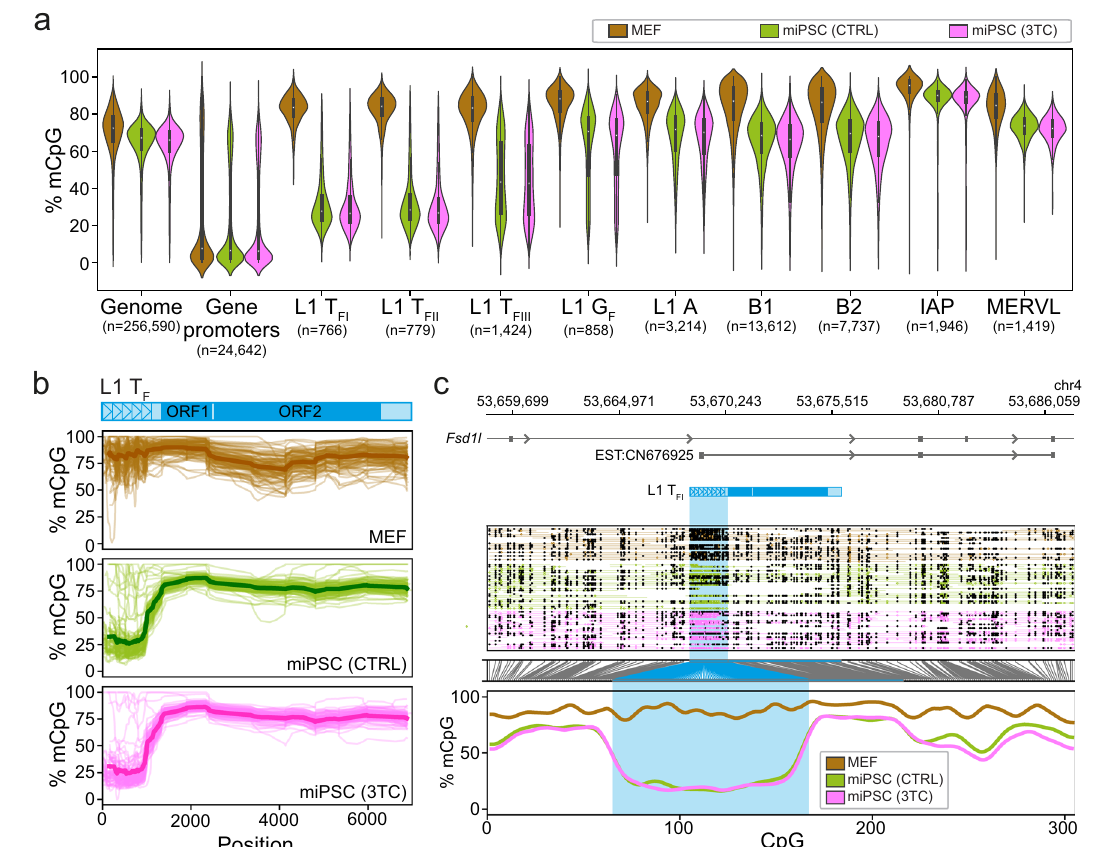
Fig. 4 | Genome-wide methylation analyses via ONT sequencing. a CpG methy- lation ascertained by ONT sequencing of MEFs (brown), control miPSCs (CTRL, green), and miPSCs derived in the presence of lamivudine (3TC, pink). Results are shown for the whole genome (10kbp windows), the proximal promoters ( − 1000, +500)ofprotein-codinggenes 119 ,the5 ′ UTRofT F ,G F ,andA-typeL1s>6kbp,B1and B2 SINEs, and MERVL MT2 and IAP long terminal repeats. Note: the 6 control and 3TC-treated miPSC replicates are displayed in aggregate to compare against the single MEF replicate, and the number of elements in each category is shown underneath. Box plots indicate the median, interquartile range, and 1.5× inter- quartile range. b Composite L1 T F methylation pro fi les. Each graph displays 100 pro fi les. A schematic of the T F consensus is provided at top. Average values are indicated by more thickly colored lines. c , Methylation pro fi le of the Fsd1l locus obtainedbyONTsequencing.The fi rstpanelshowsanL1T F orientatedinasenseto